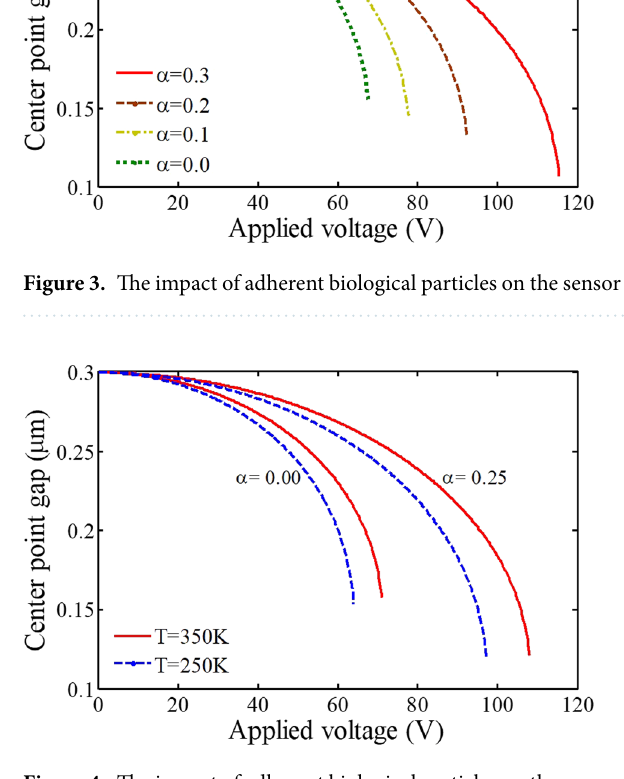
Figure 4. The impact of adherent biological particles on the sensor behavior at different